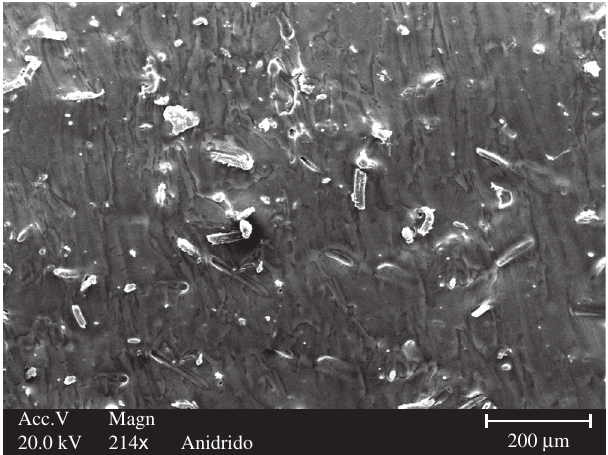
Figure 4. Scanning electronic micrographs of SBS/5% short sisal fiber composites processed in a double-screw extruder with maleic anhydride as coupling